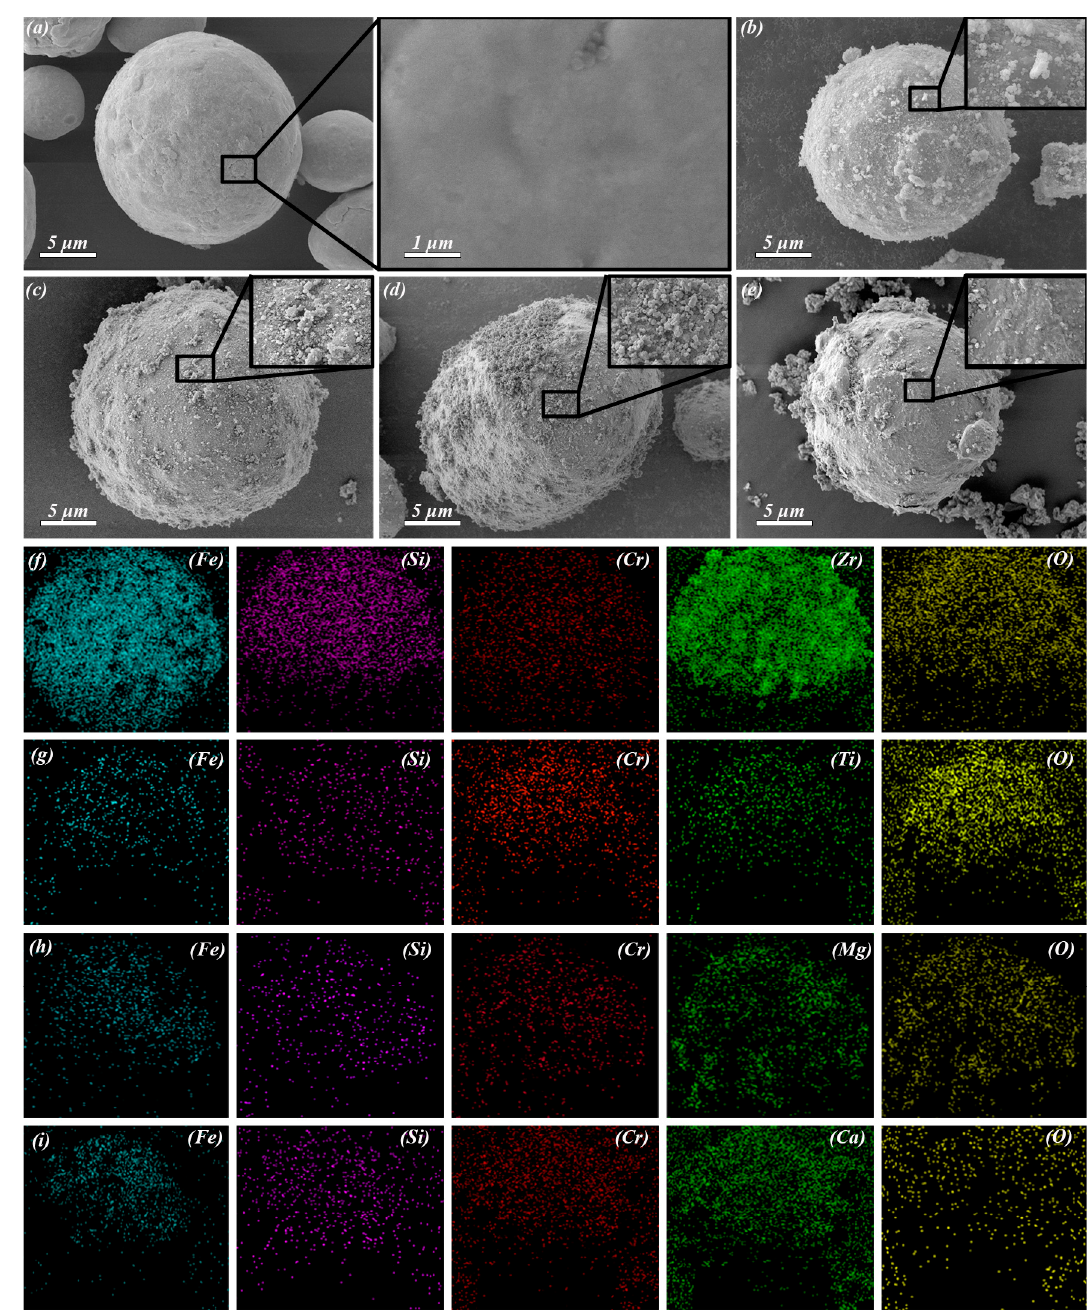
Figure 2. SEM images and EDS results showing the surface morphology and elemental distribution of ( a ) raw Fe-Si-Cr alloy powder and ( b – i ) Fe-Si-Cr/AO x composite powders coated with varying metal oxide layers. ( b , f ) Fe-Si-Cr/ZrO 2 , ( c , g ) Fe-Si-Cr/TiO 2 , ( d , h ) Fe-Si-Cr/MgO, and ( e , i ) Fe-Si-Cr/CaO.